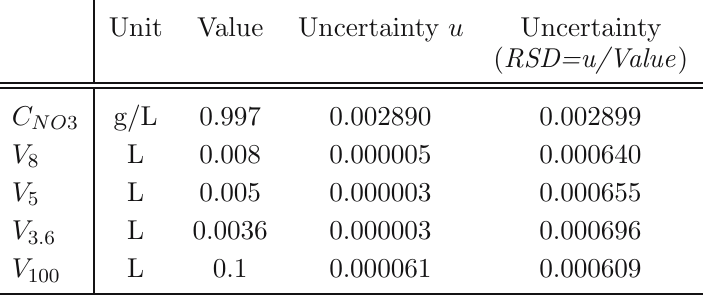
Table 1 Uncertainty components and their relative standard uncertainty of nitrate work- ing reference solutions.